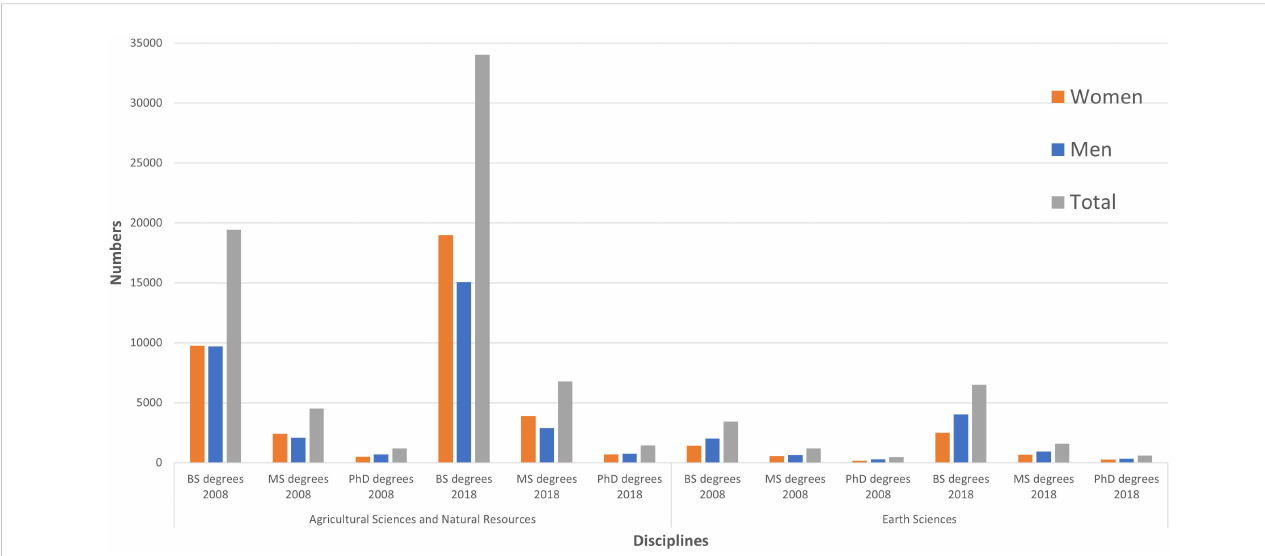
FIGURE 2 Science and engineering degrees, by race and ethnicity of recipients in the U.S.: 2008 – 2018. Data by fi eld of degree and citizenship status of recipients. These categories include U.S. citizens and foreign citizens on permanent visas (i.e., resident aliens who have been admitted for permanent residency). Data retrieved from the National Center for Science and Engineering